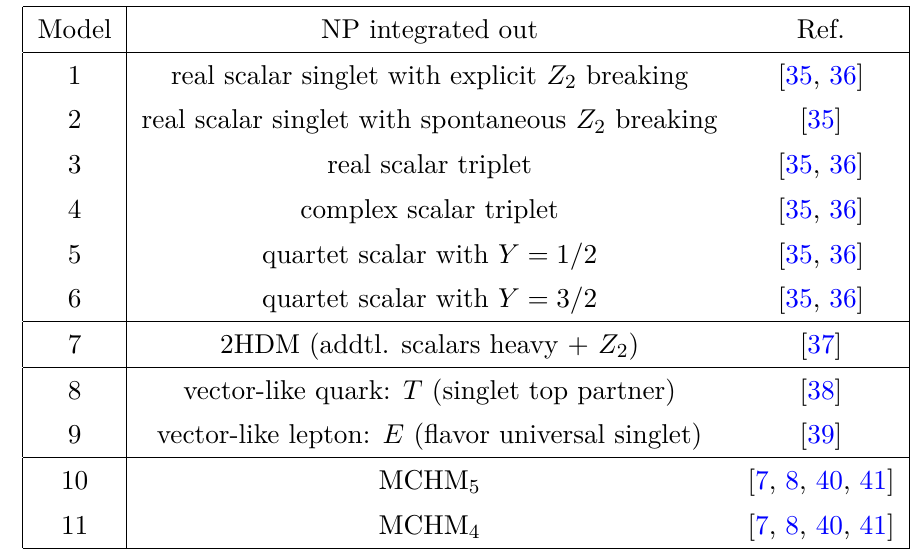
Table 5 . Explicit models considered in this